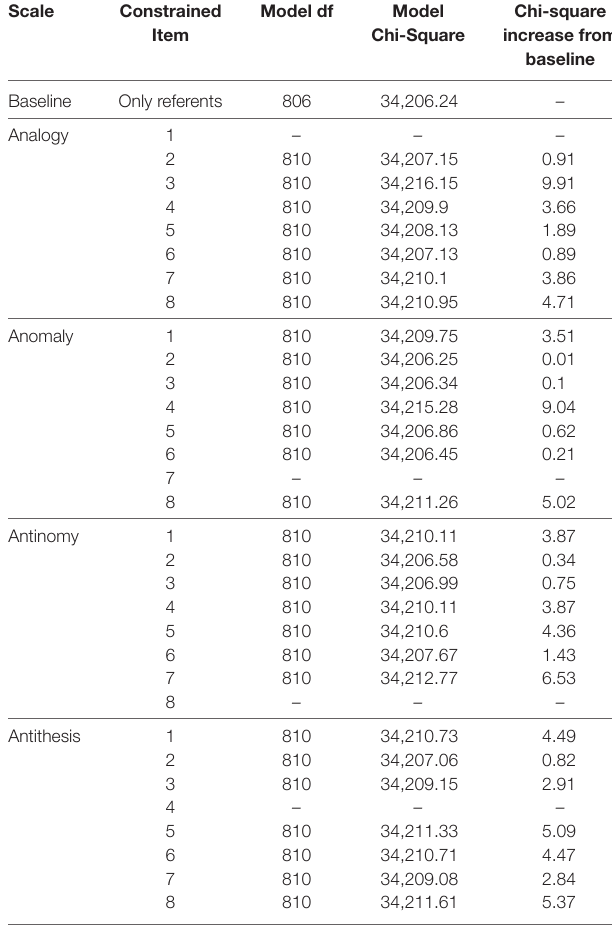
taBlE 10 | Likelihood-ratio tests for differential item functioning between white and asian participants.